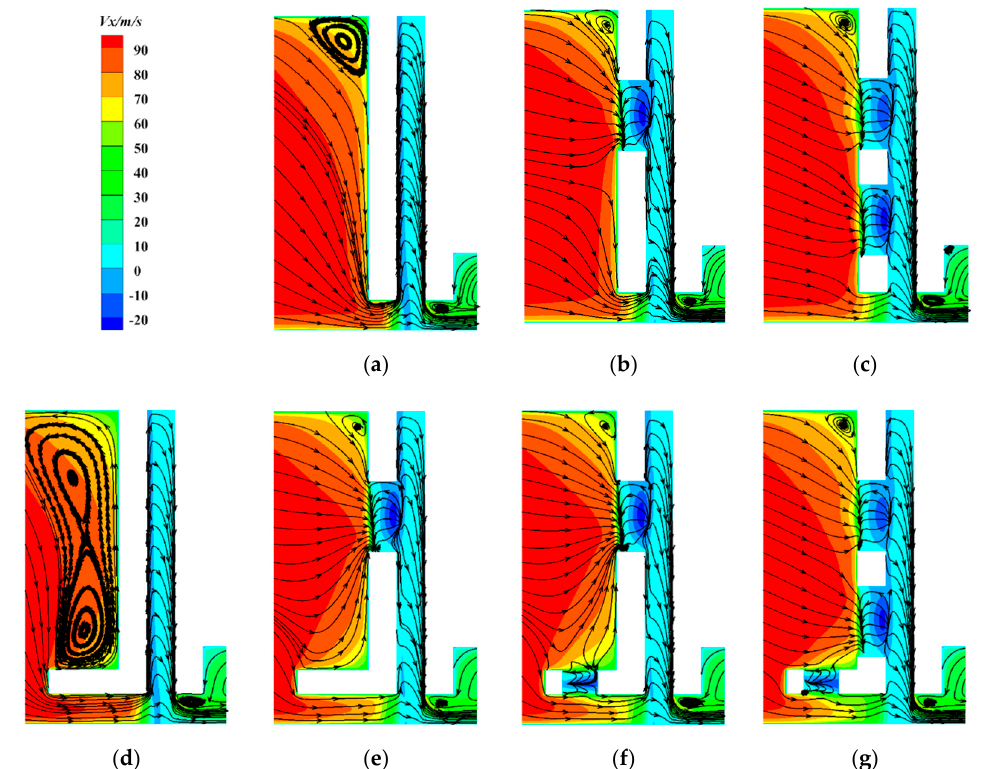
Figure 10. Swirl velocity contours and streamlines: ( a ) Case-1; ( b ) Case-2; ( c ) Case-3; ( d ) Case-4; ( e ) Case-5; ( f ) Case-6; ( g ) Case-7.